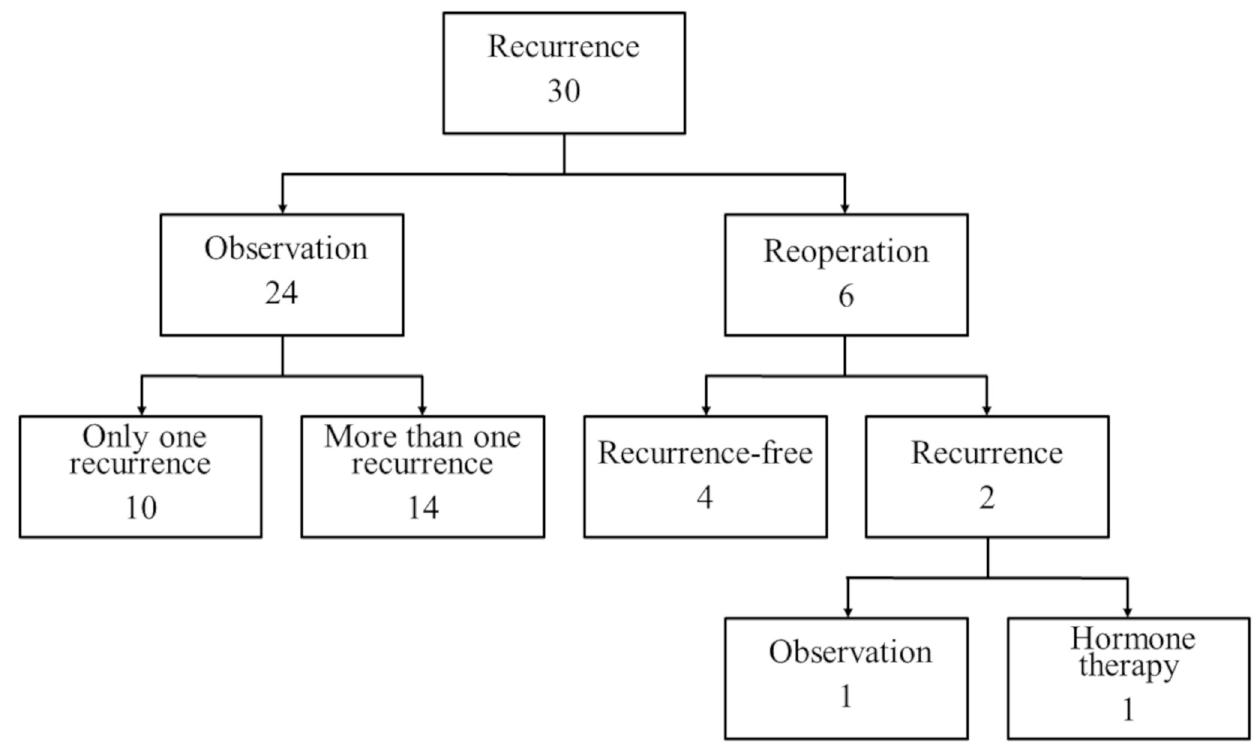
Fig 5. Flow chart of treatments for 30 patients with postoperative recurrences.